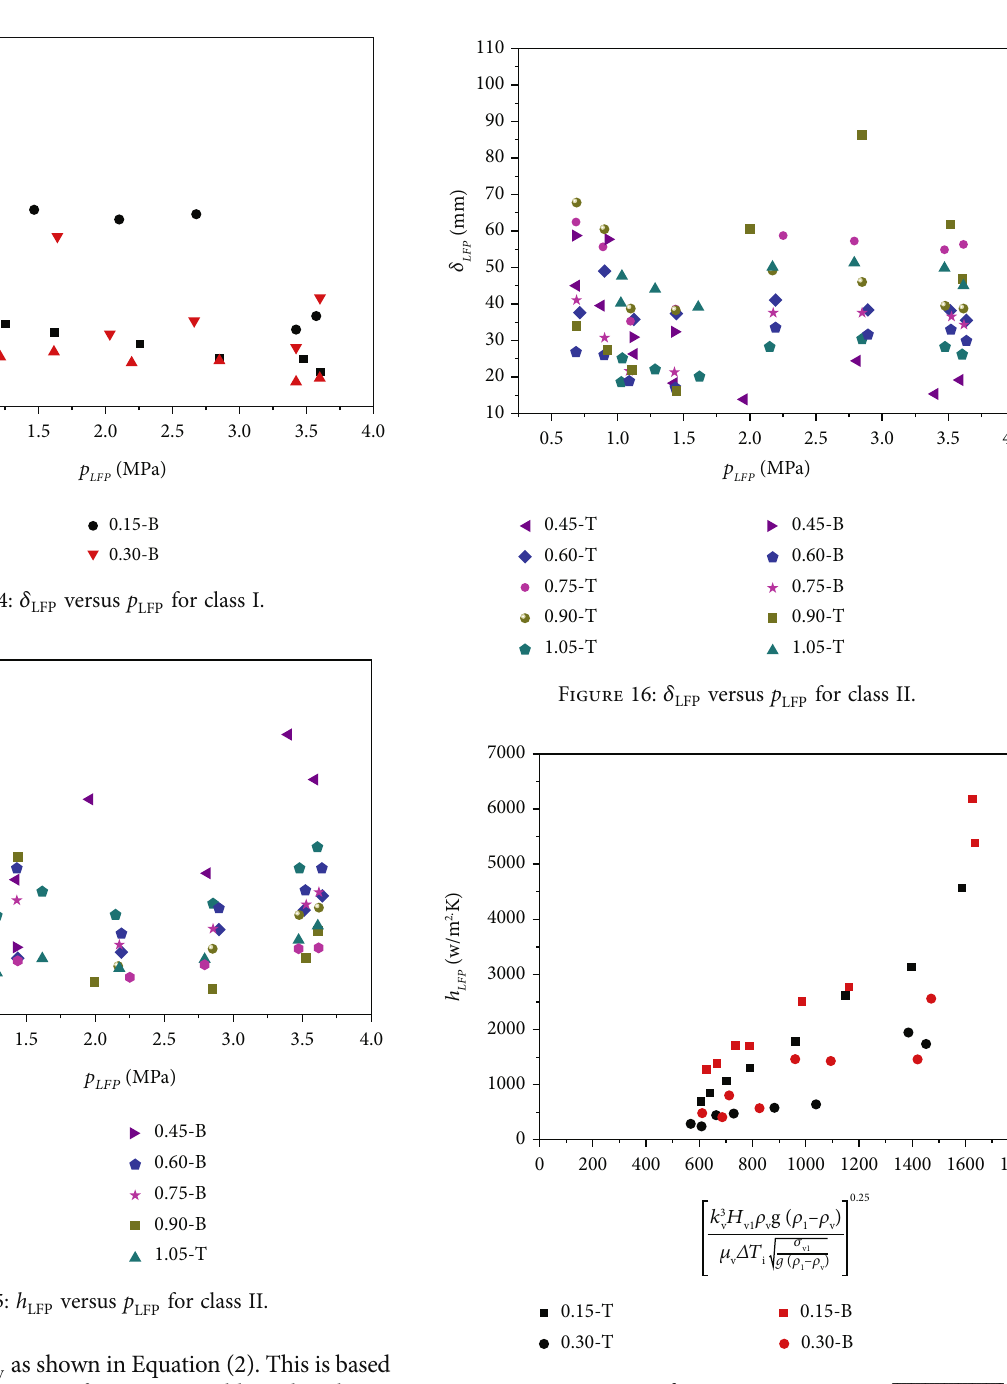
Figure 17: h for cross-sections in Class I.